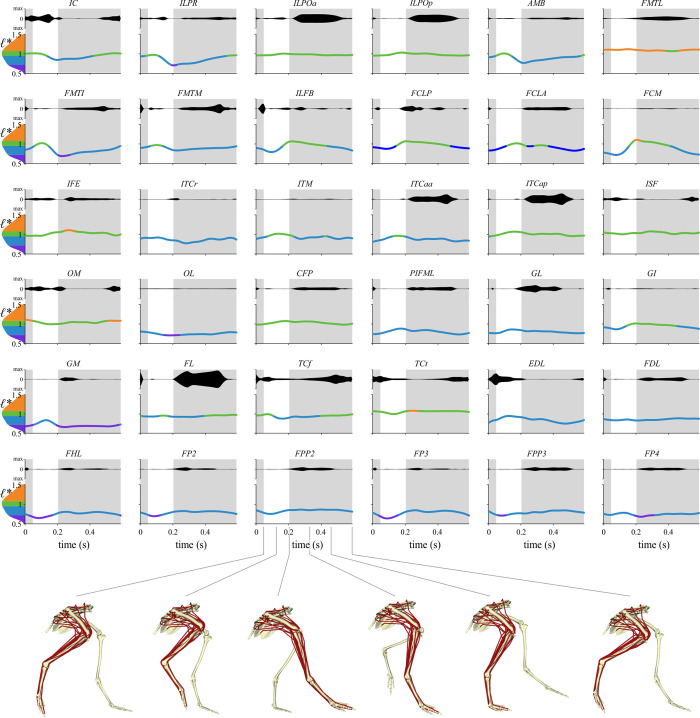
Time histories of muscle excitation and fibre length change for each MTU in the walking simulation.Excitations (from zero recruitment to possible maximal recruitment) are plotted above normalized fibre lengths for each MTU, the latter of which are colour coded according to where on the active force–length curve fibres are operating: purple = steep ascending limb, blue = shallow ascending limb, green = plateau, orange = descending limb (divisions approximately correspond to those of Arnold and Delp [15]). Excitation profiles obtained in the simulation are reflected about the abscissa so as to visually emulate the appearance of experimental EMG signals. Grey regions denote the stance phase, white regions denote the swing phase. See Table 2 for muscle abbreviations.